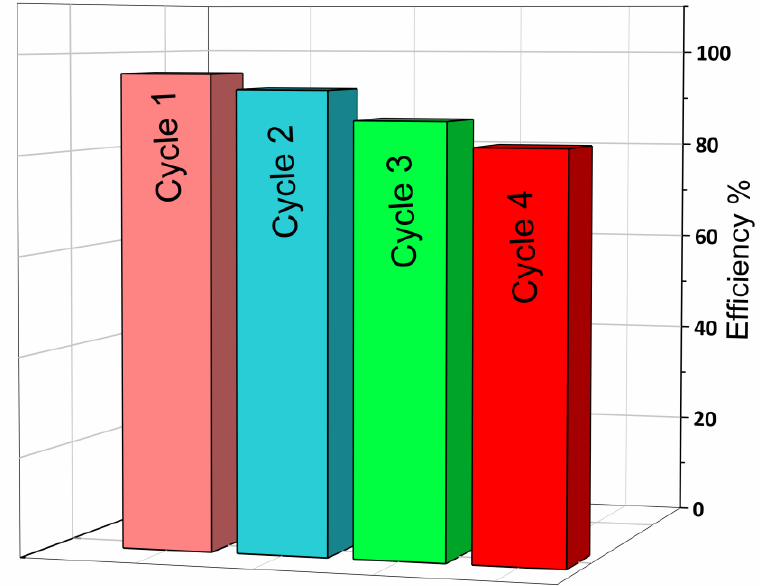
Figure 7. Discoloration performance of recycled catalyst ([RhB] = 0.01 mM; irradiation time= 12 min; [Catalyst] = 1.0 g/L; room temperature).